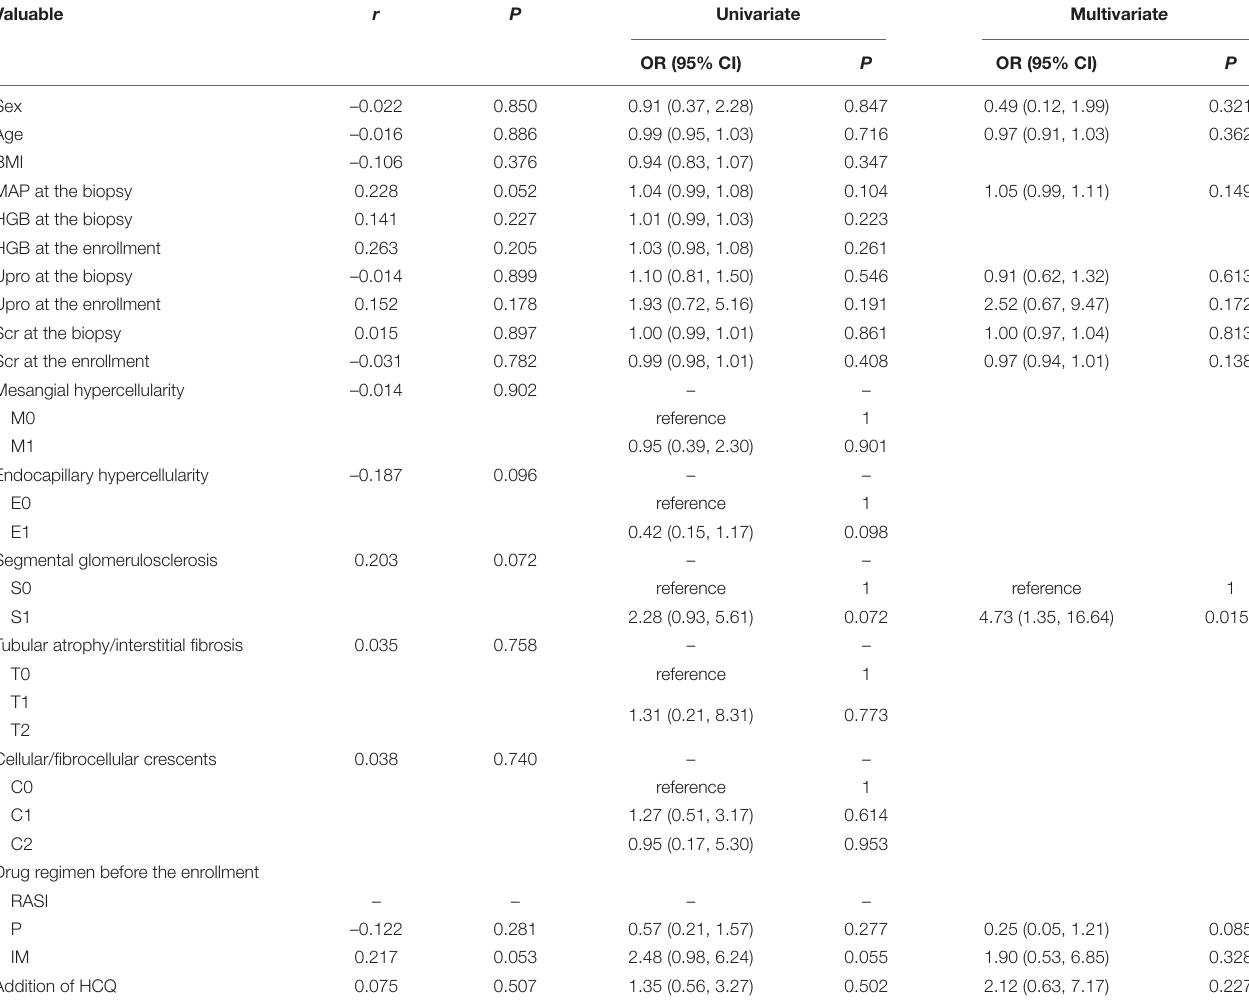
TABLE 5 | Clinicopathological features associated with the effective reduction frequency in residual proteinuria in patients treated with RASI or HCQ + RASI.